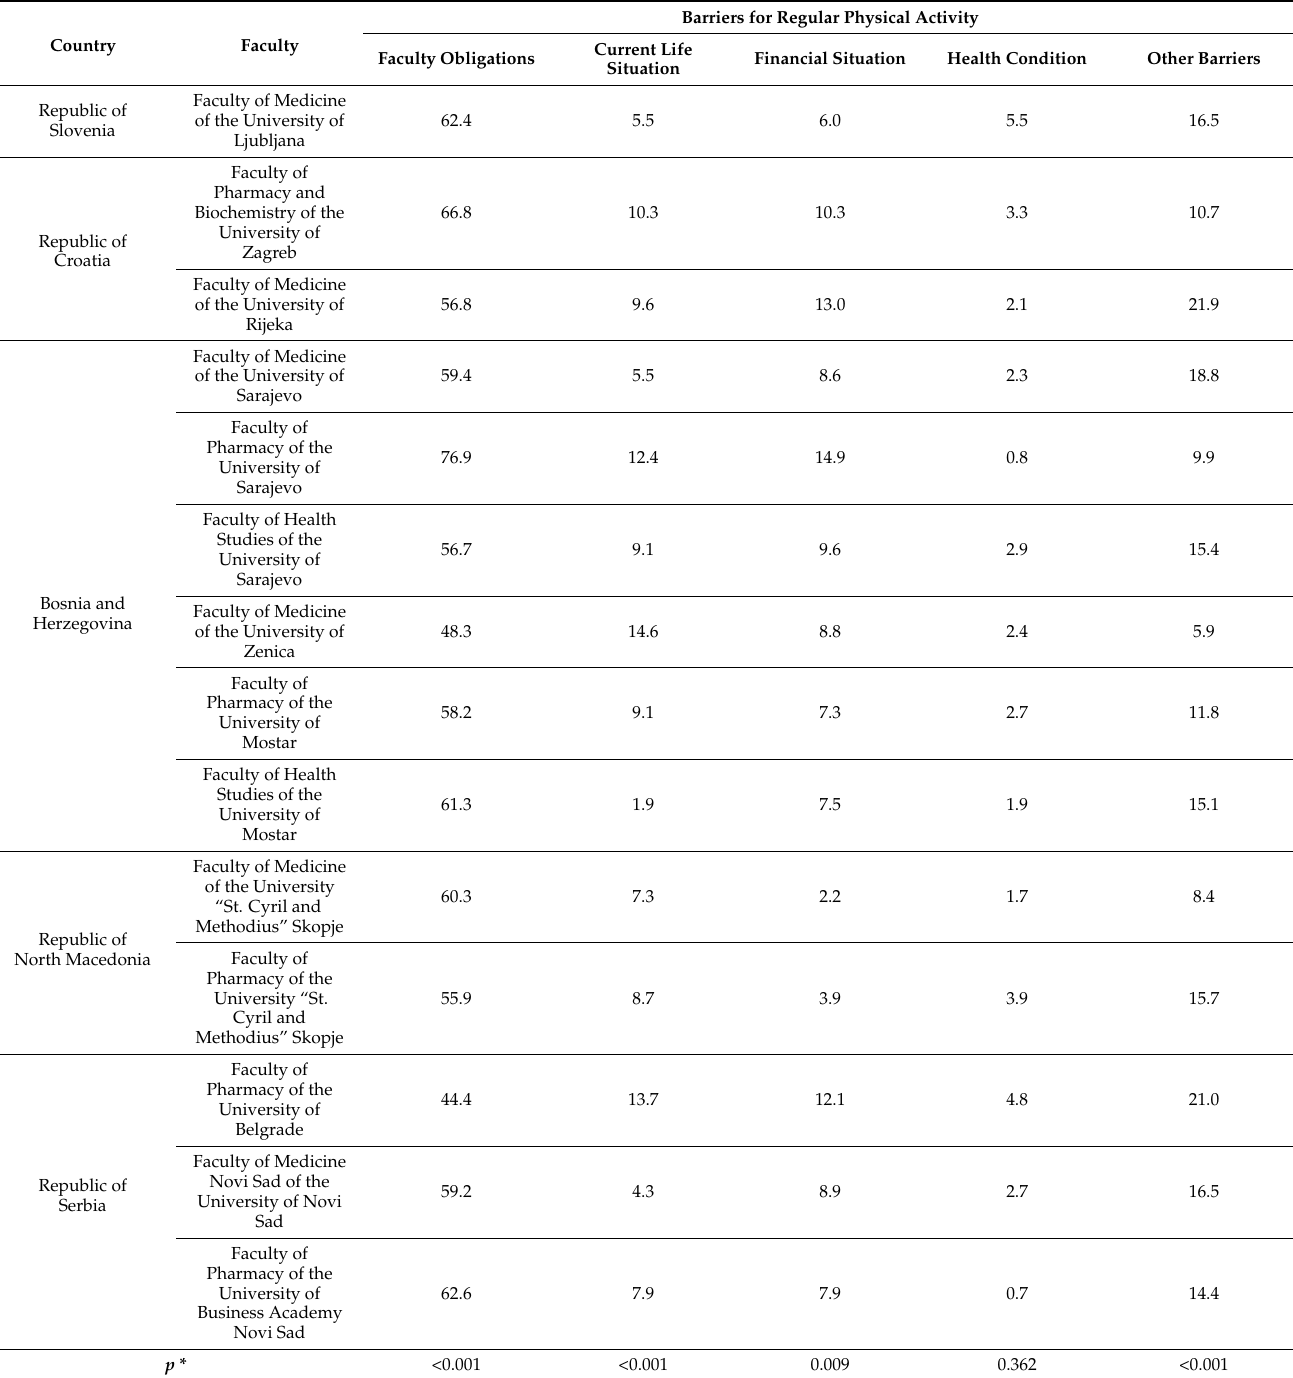
Table 6. Barriers for regular physical activity among medical students, in relation to the attended faculty